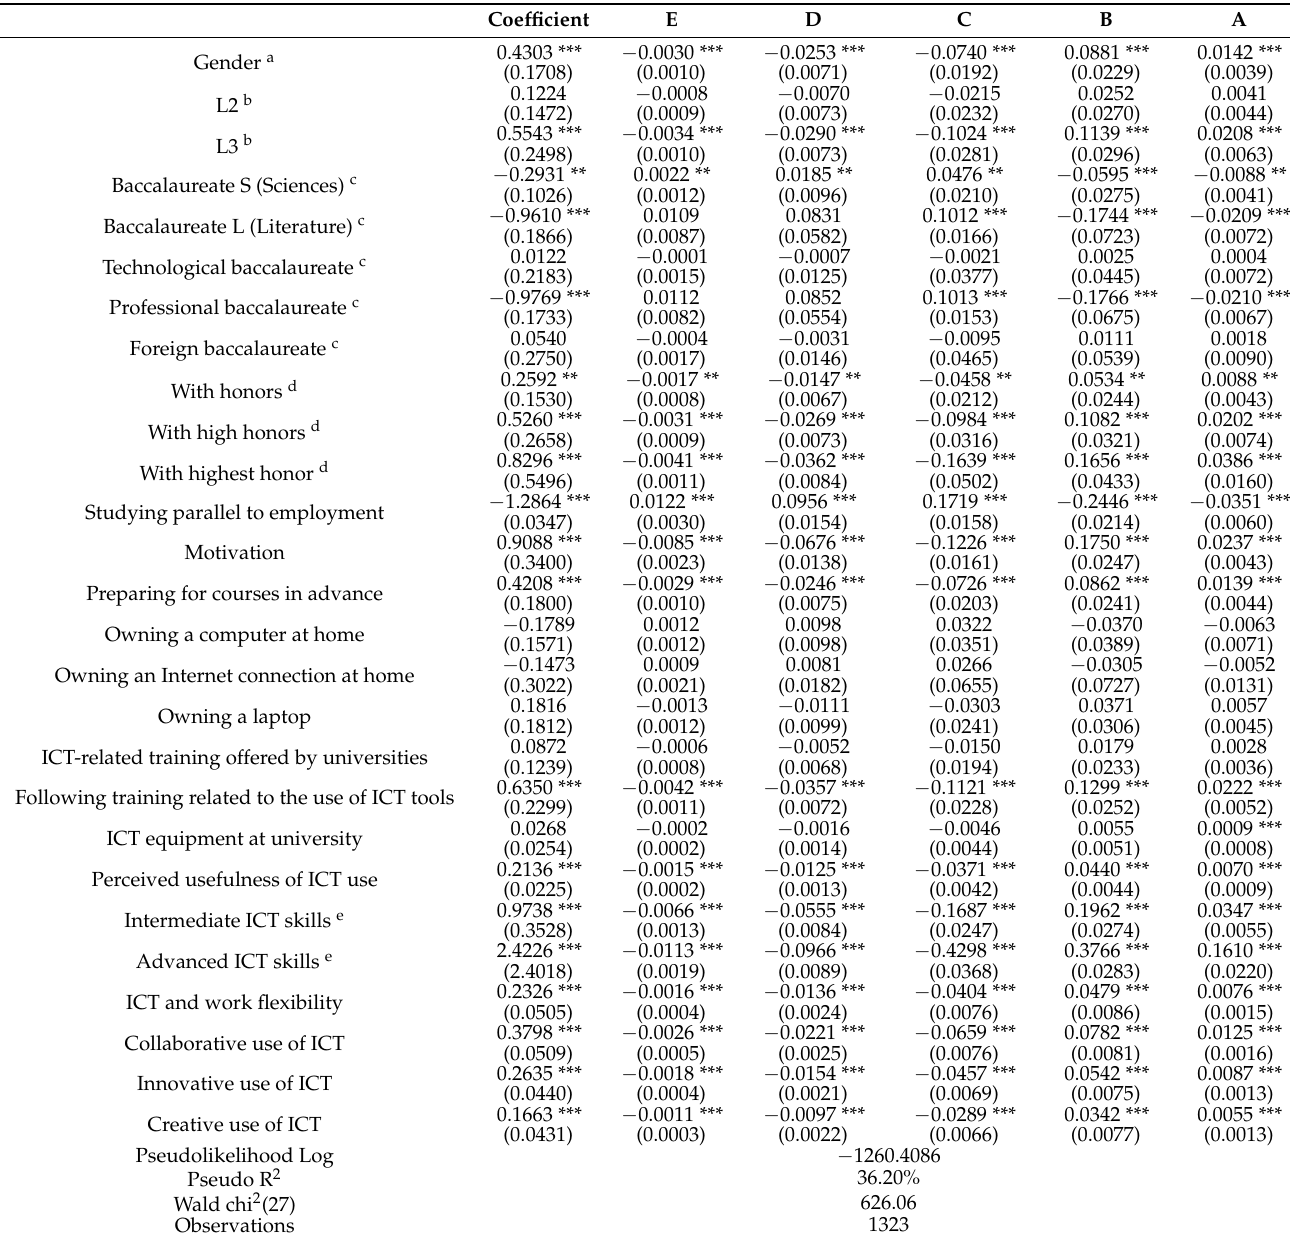
Table 7. Estimates of marginal effects—Model 2 f,g :